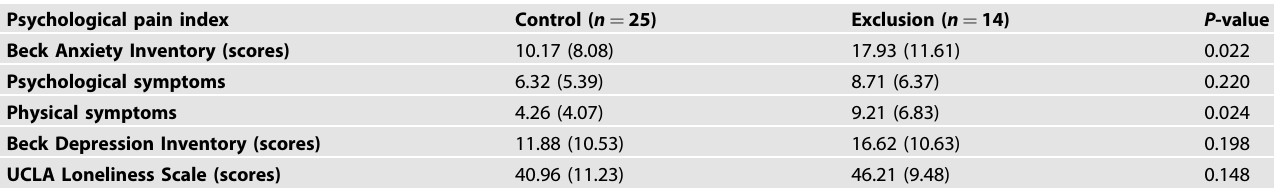
Table 2. Psychological pain status of